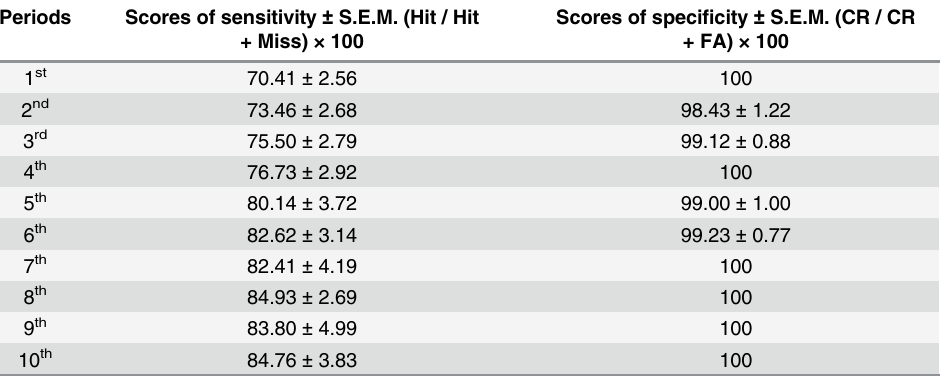
Table 1. Proportion of correct detections (sensitivity scores: number of Hits / [Hits + Misses]) and False Alarms (specificity scores: number of CR / [CR + FA]) throughout the 10 periods of continuous